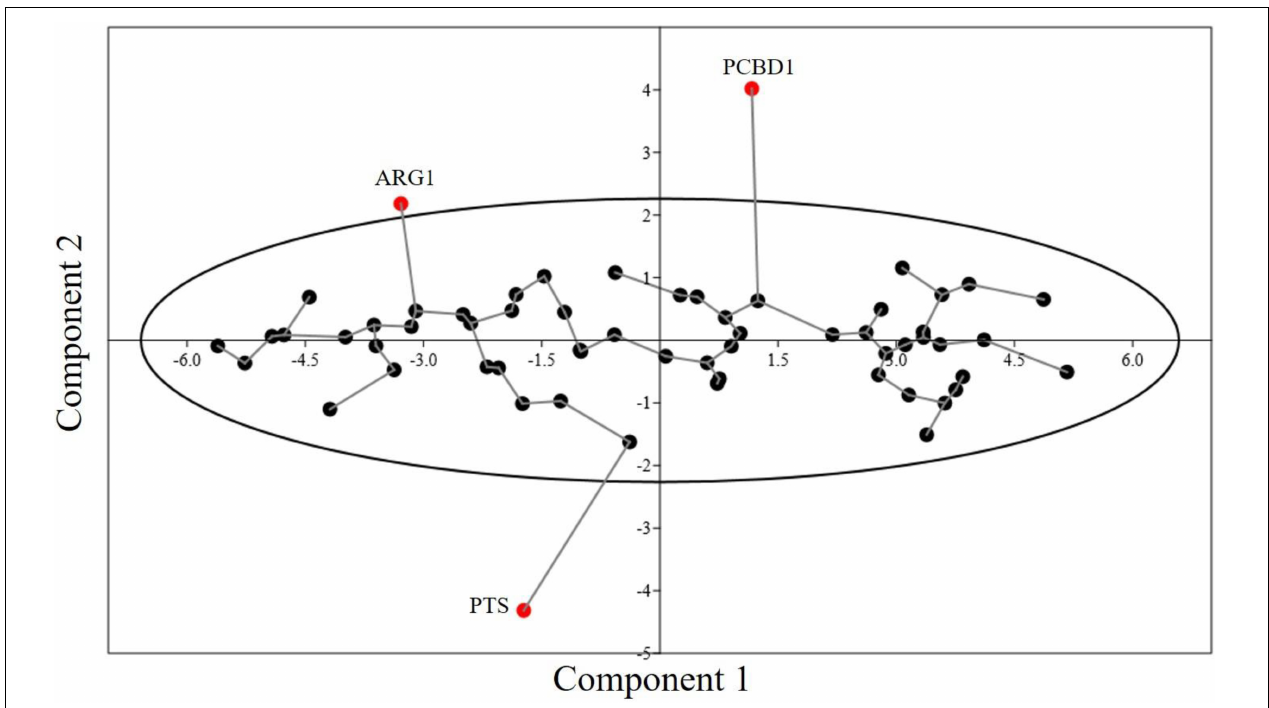
FIGURE 7 | Minimum spanning tree graph for PCA of 60 genes involved in neurodegeneration. The eclipse shows a 90% concentration of genes within the area. Three genes are present outside the concentration eclipse, showing different behavior. TABLE 4 | The genes showing unusual behavior in terms of codon usage. S.